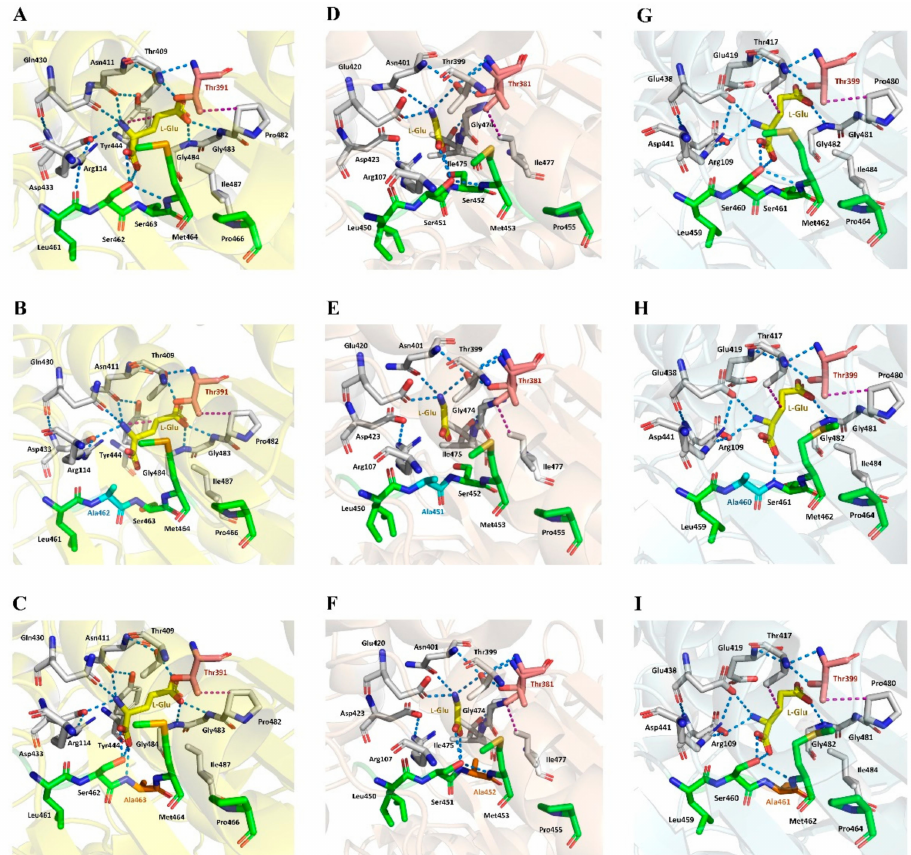
Figure 4. Enzyme-L-glutamate interactions within the substrate-binding pockets of Ec GGT, Hs GGT, and Bl GGT. The crystal structures of Ec GGT (2DBX) and Hs GGT (4GDX) were individually used as the templates to fabricate the predictive models of S462A- Ec GGT, S463A- Ec GGT, S451A- Hs GGT, and S452A- Hs GGT. Hydrogen-bonding and hydrophobic interaction are indicated by blue and purple dotted lines, respectively. The carbon skeletons of the conserved PLSSMXP sequence, catalytic threonine, and enzyme-bound l -glutamate are shown in green, pink, and yellow colors, respectively. Panels: ( A ) Ec GGT [18], ( B ) S462A- Ec GGT, ( C ) S463A- Ec GGT, ( D ) Hs GGT [21], ( E ) S451A- Hs GGT, ( F ) S452A- Hs GGT, ( G ) Bl GGT [20], ( H ) S460A, and ( I )